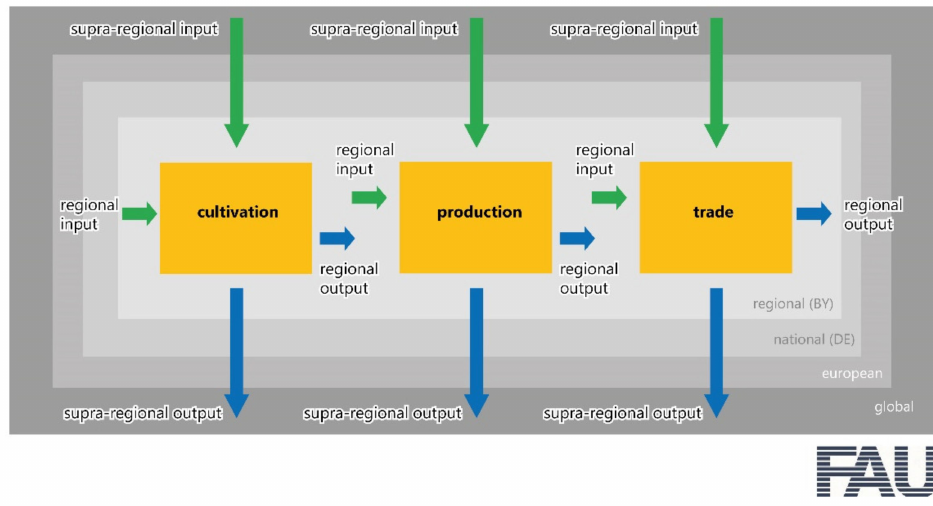
Figure 1. The value creation mapping